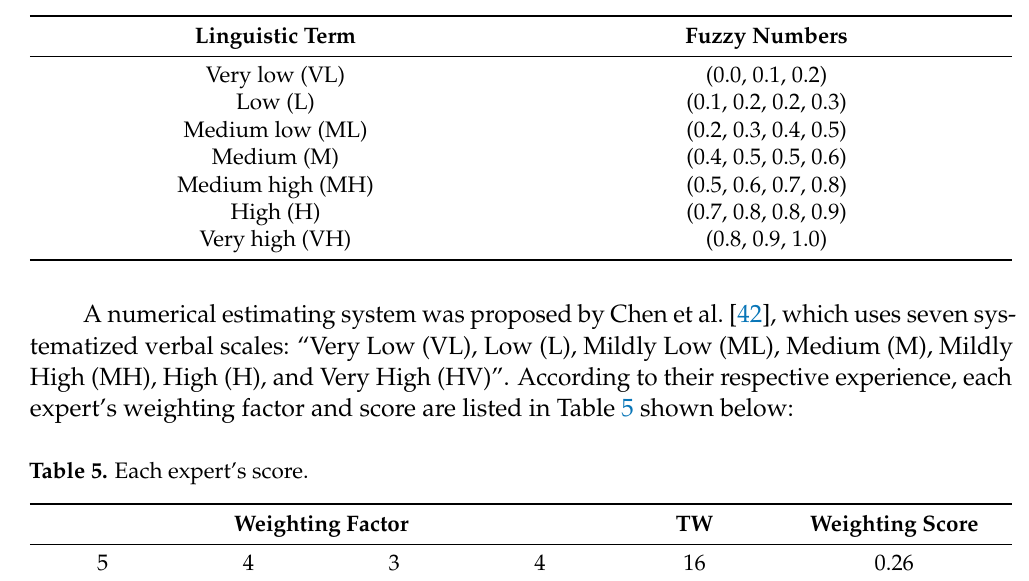
Table 4. Verbal terms and equivalent fuzzy numbers [18].